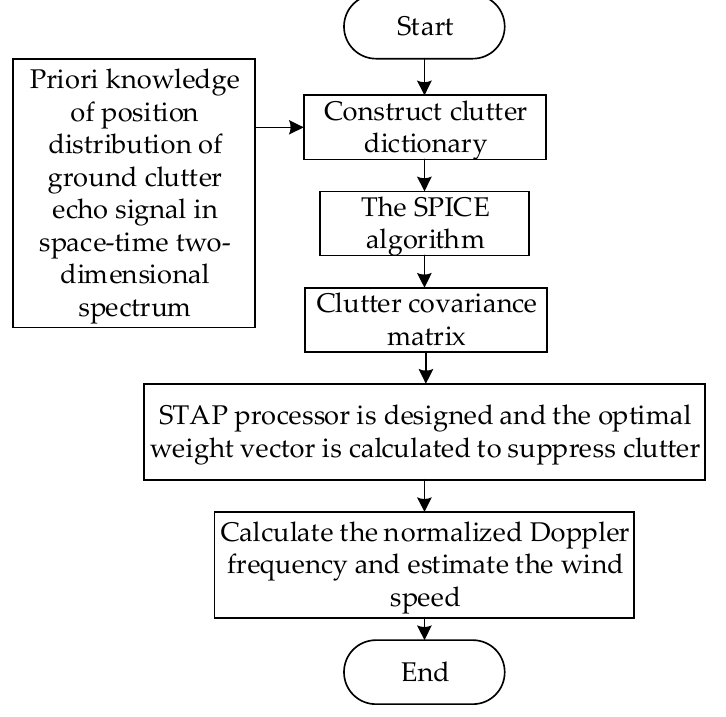
Figure 4. Flow diagram of low-altitude windshear wind speed estimation method based on KASPICE-STAP.